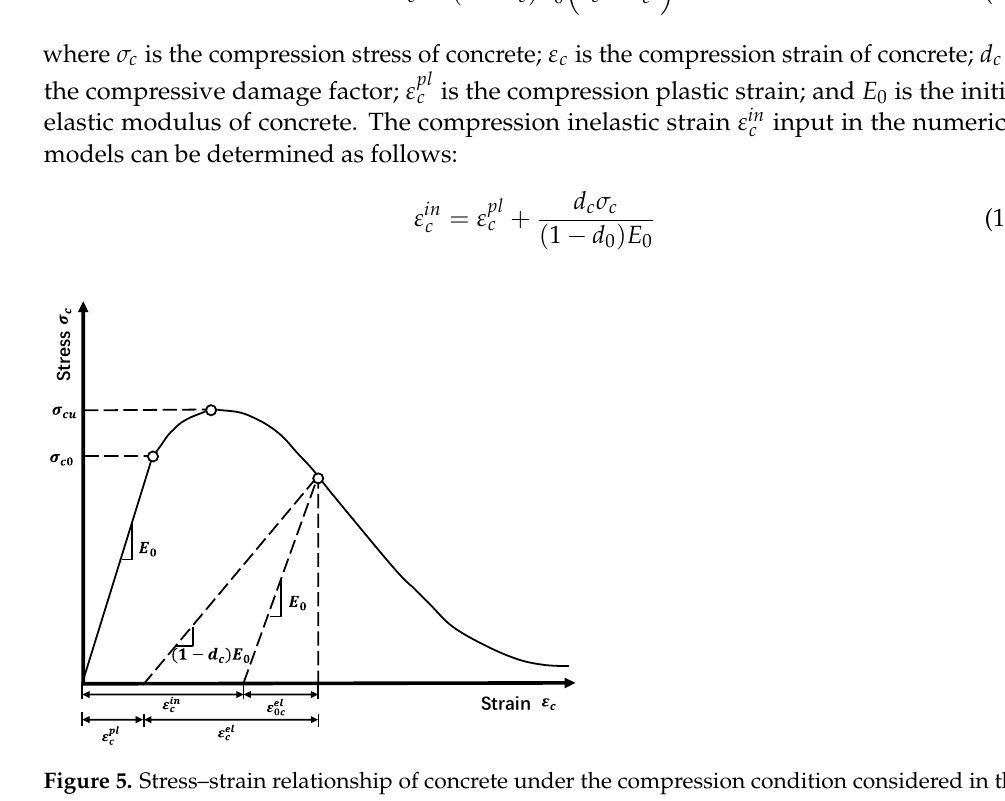
Figure 4. Stress–strain relationship of concrete under the tension condition considered in the pre- sent study.